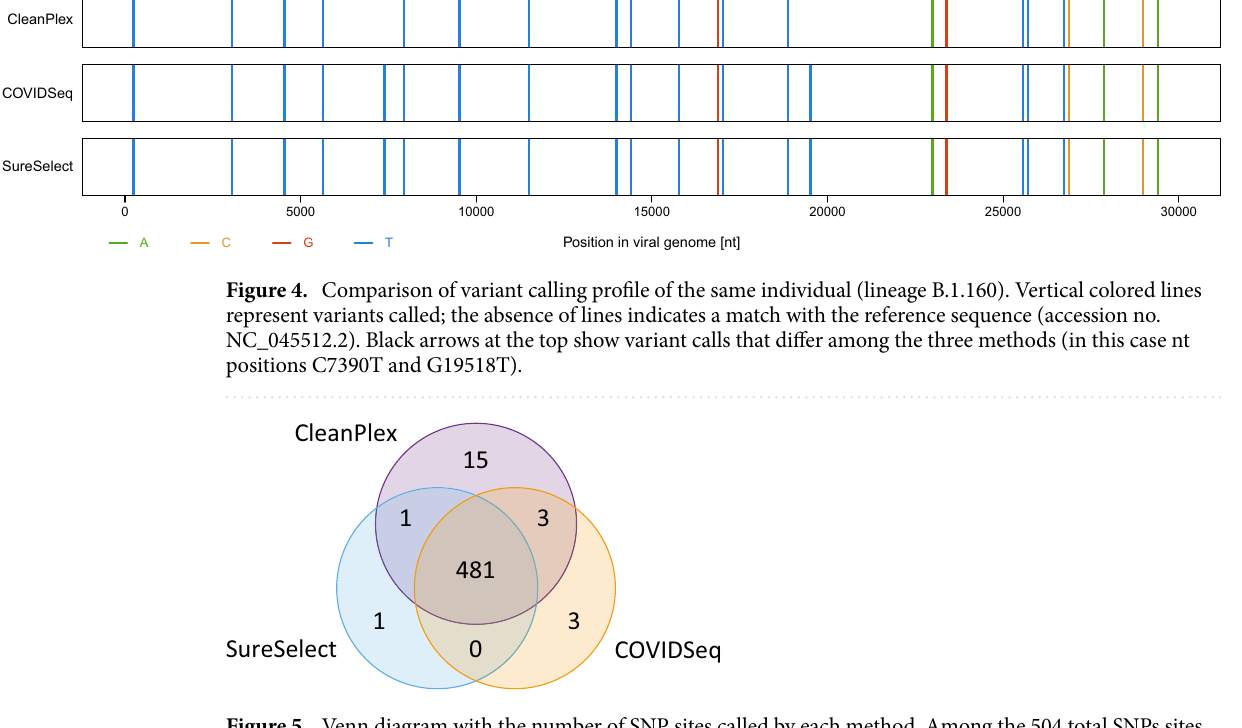
Figure 5. Venn diagram with the number of SNP sites called by each method. Among the 504 total SNPs sites observed in this study, 23 were not called consistently by all three